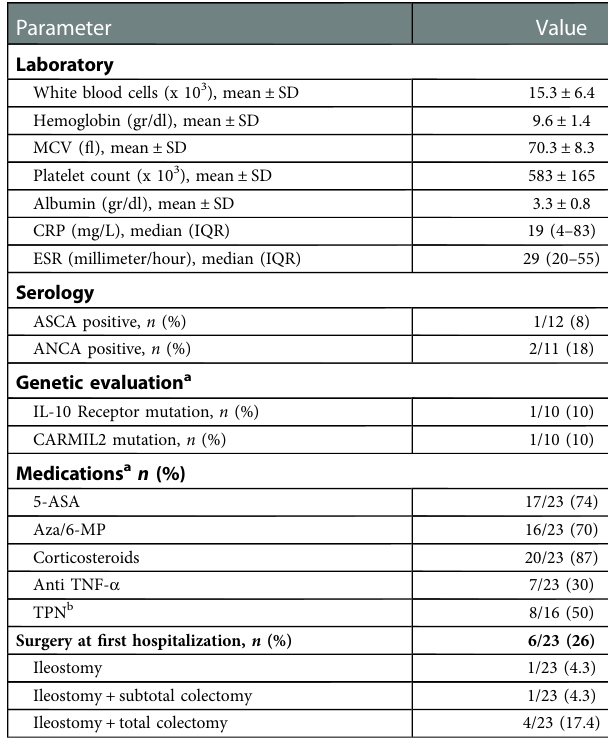
TABLE 2 Laboratory data at presentation and initial treatment in children with infantile-onset in fl ammatory bowel